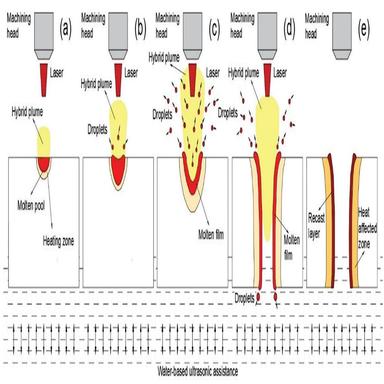
Schematic of different stages for (a) initial melting with plume generation, (b) initial ejection formation, (c) blind hole formation and (d) through hole formation as well as (e) after laser irradiation during a laser drilling process assisted by water-based ultrasonic vibrations without using assist gas.